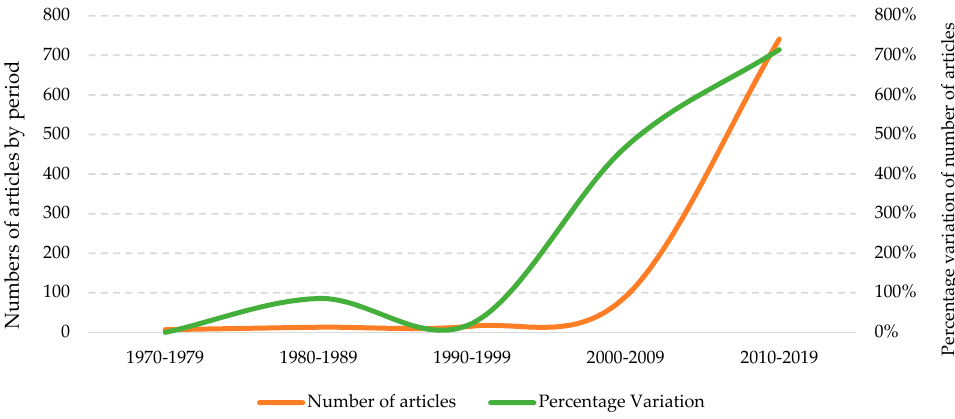
Figure 3. Evolution of the number of articles and percentage of variation (1970–2019).